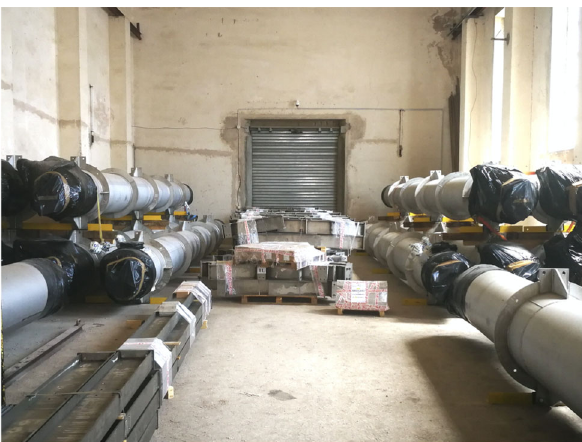
Fig. 3 ThecentralmodulesofthecolumnstoredatCarbosulcisS.p.A., Nuraxi-Figus site, ready for installation